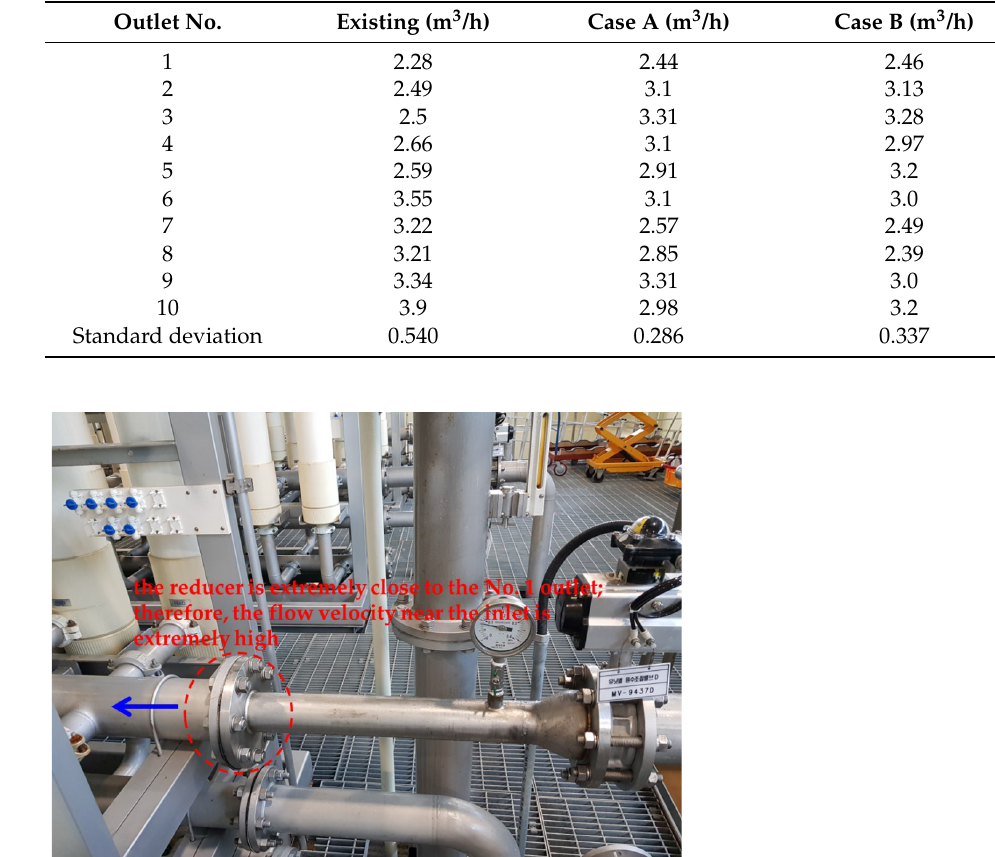
Table 3. Comparison of verification experiments results.